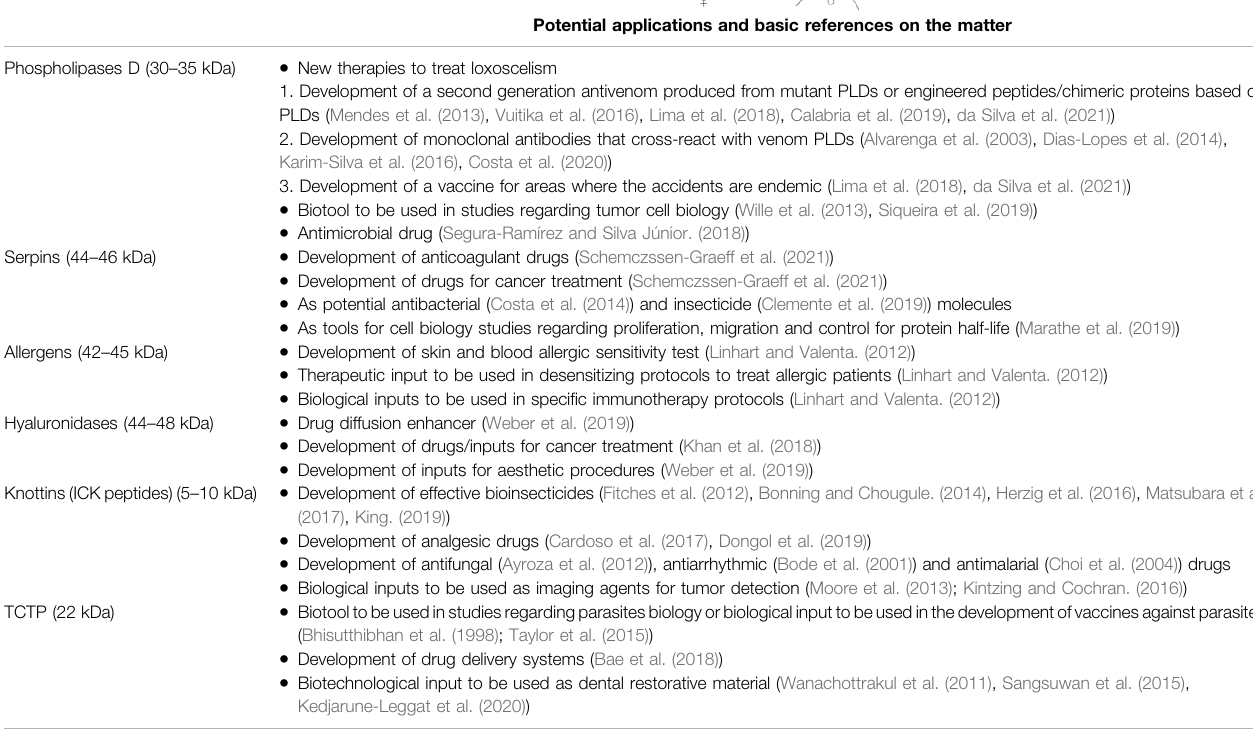
Brown spider venom